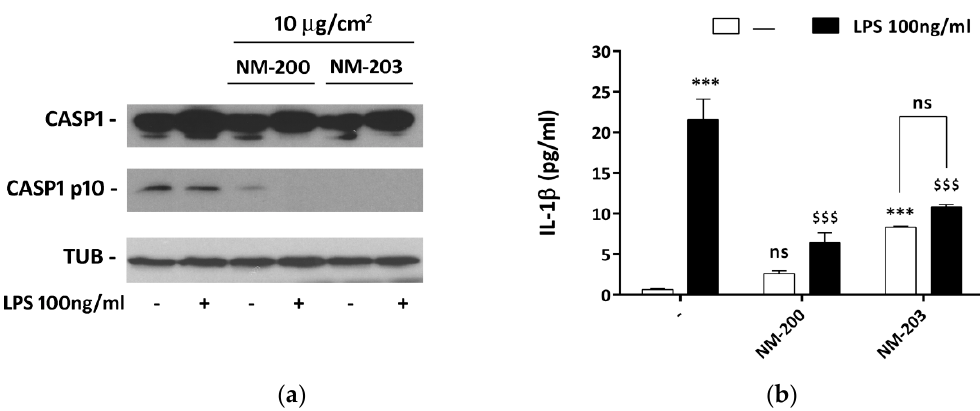
Figure 5. Caspase-1 cleavage and IL-1 β secretion in ASNP-treated macrophages. THP-1 cells were incubated for 24 h with NM-200 or NM-203. The incubation was then prolonged with or without LPS. Cells were extracted for caspase-1 expression after 24 h of LPS treatment, while the culture media were collected for the determination of IL-1 β after 2 h. In panel ( a ), a representative experiment is shown, performed twice with comparable results. In panel ( b ), data are shown as means of three independent determinations ± SD. *** p < 0.001 vs. control, untreated cells; $$$ p < 0.001 vs. LPS-treated cells not pre-exposed to ASNP; ns, not significant vs. the corresponding condition with LPS, one-way ANOVA.